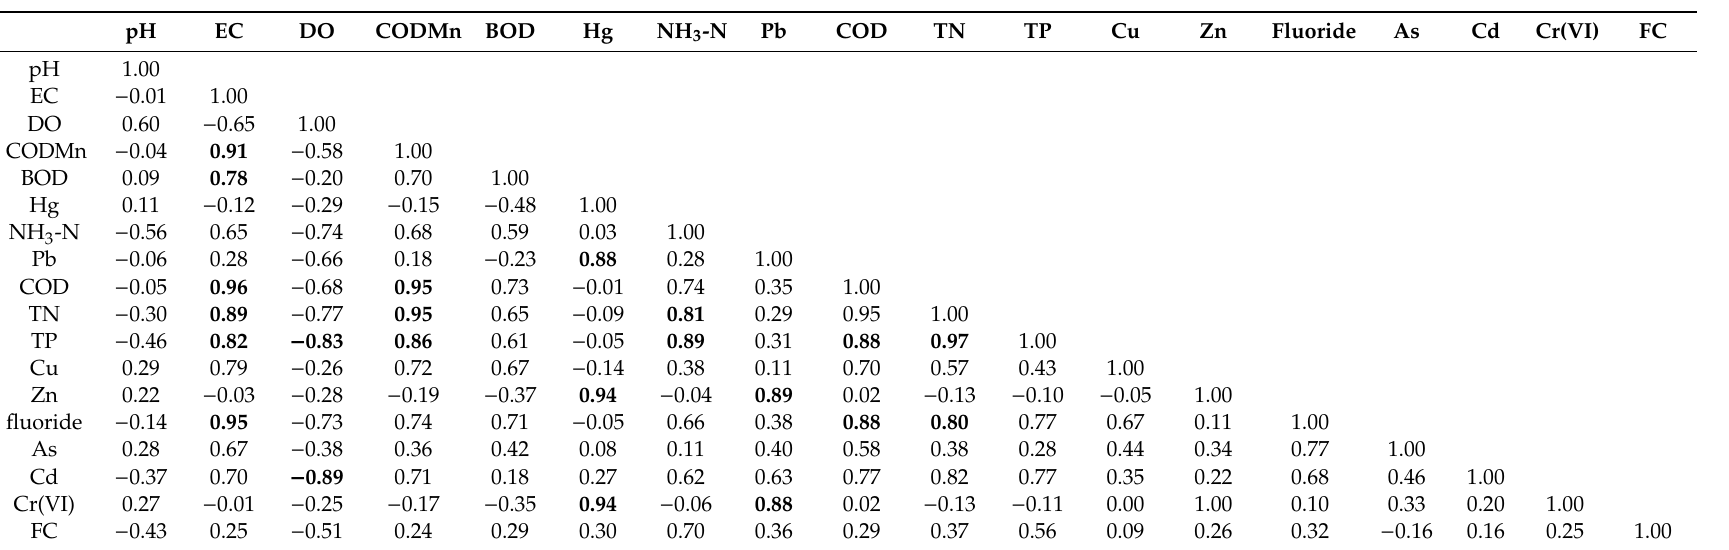
Table 1. Correlation coe ffi cient matrix.